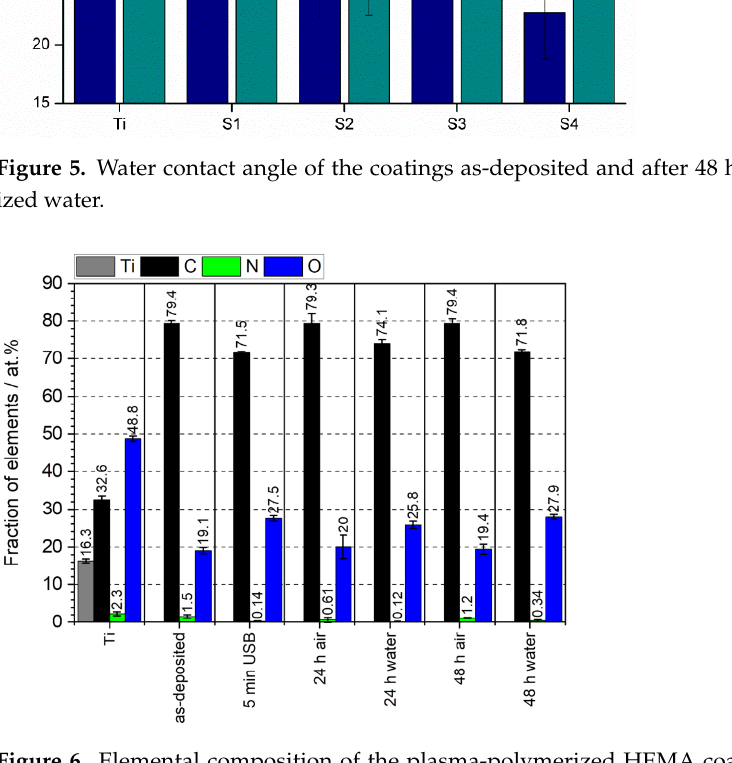
Figure 6. Elemental composition of the plasma-polymerized HEMA coatings as deposited after 5 min of ultrasonic treatment (USB) and of the coatings being stored in air or water for 24 h and 48 h, respectively.